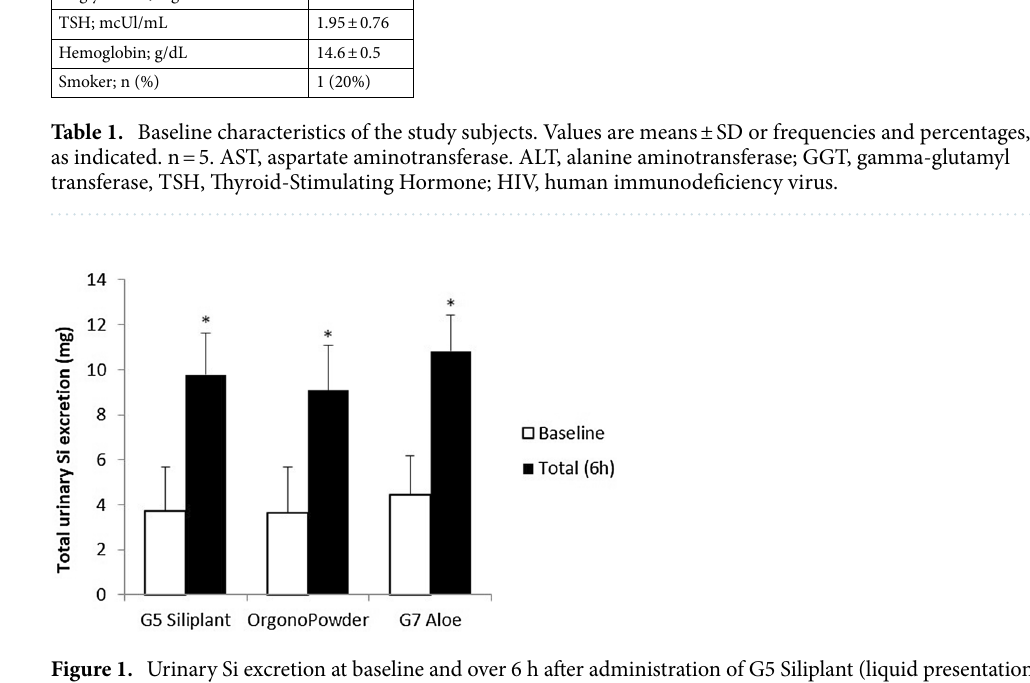
Figure 1. Urinary Si excretion at baseline and over 6 h after administration of G5 Siliplant (liquid presentation), Orgono Powder (powder presentation) and G7 Aloe (liquid presentation; all containing 21.6 mg of Si) in healthy subjects. The results are expressed as total milligrams excreted in urine. Values are the mean ± SD (n = 5) *, p < 0.05 with respect to